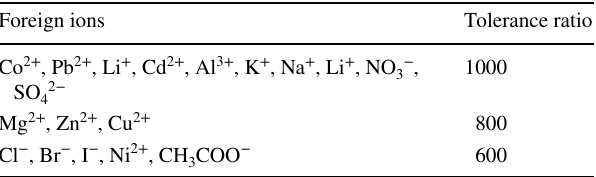
Table 6 Tolerance limit of foreign ions on the determination of 0.15 µg mL −1 of BG Foreign ions